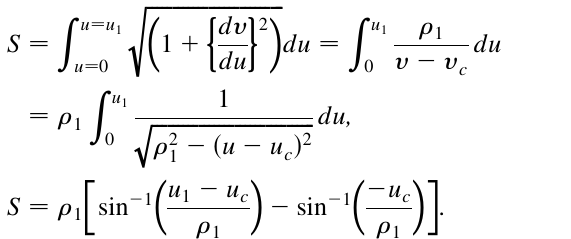
1 ffiffiffiffiffiffiffiffiffiffiffiffiffiffiffiffiffiffiffiffiffiffiffiffiffiffiffiffiffiffiffiffi